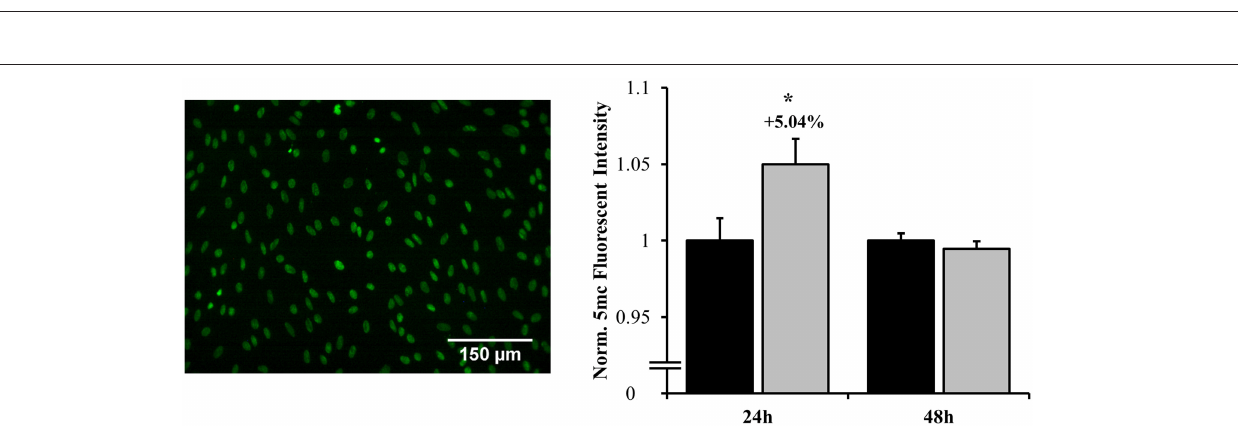
Frontiers in Neurology |